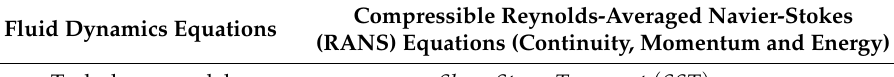
Table 1 A list of the equations and models us ed for the simulations.